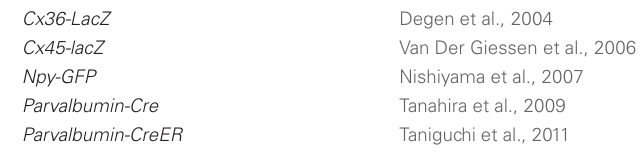
Table 1 | Molecular and genetic markers for studying olivocerebellar